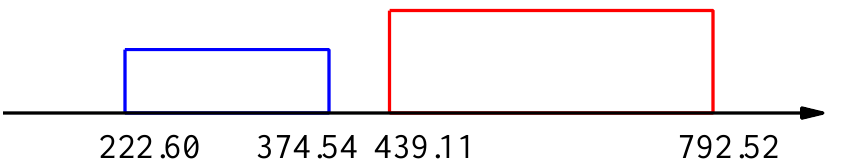
Figure 7. Comparison of stress due to dynamic torsion and ultimate tensile strength at the interval (unit: MPa).